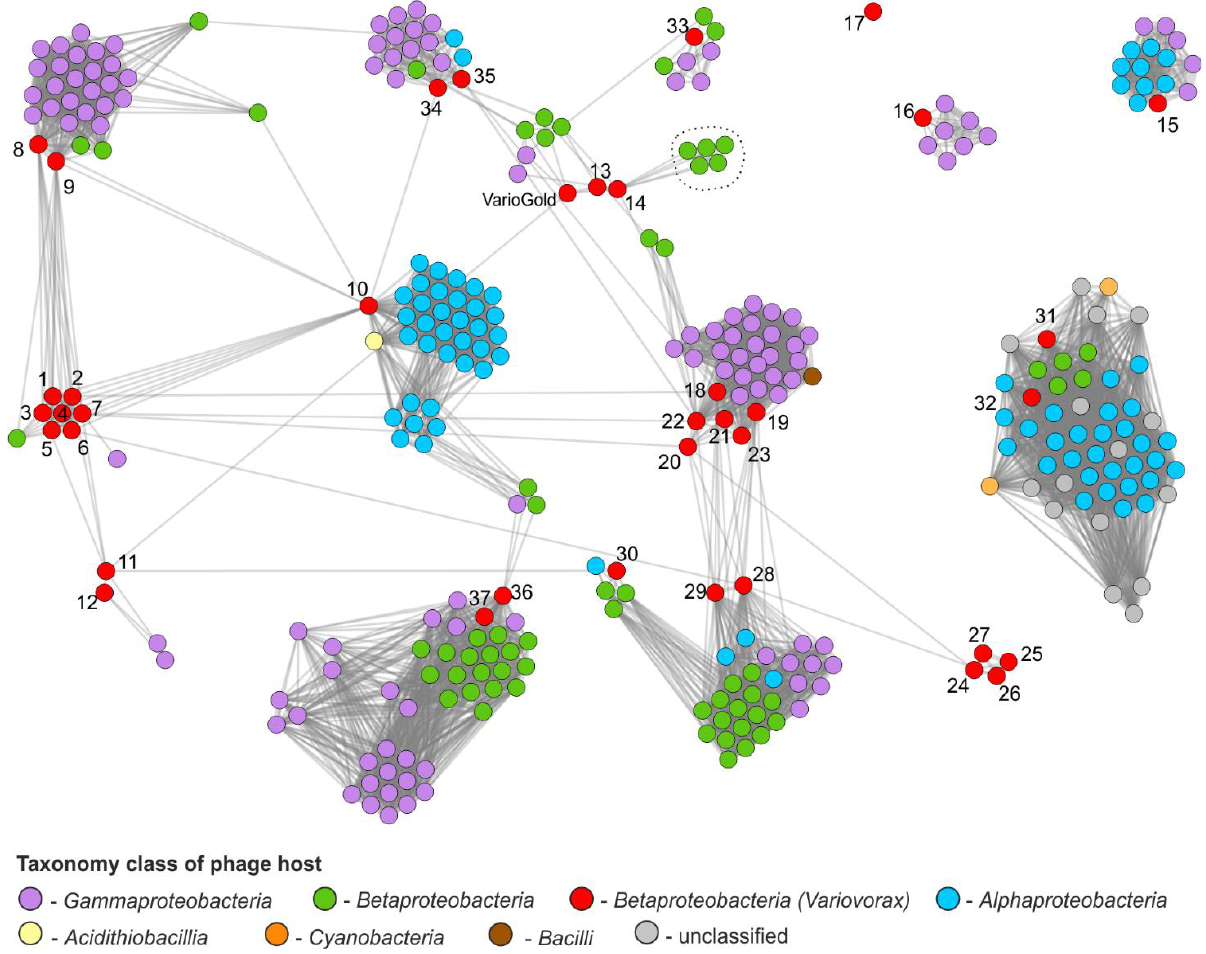
Figure 4. Proteome-based similarity network. The network was constructed with vConTACT2 to explore the diversity of Variovorax prophages in comparison with other known phages. Each node represents a single phage genome, and the edge represents a significant similarity between proteomes of connected phages. Dashed lines surrounding five phages indicate Inoviridae phages RSS0, RSS1, RSS-TH1, RS611 and RSBg infecting Ralstonia spp. Numbers next to Variovorax prophages correspond to numbering in Table 2.